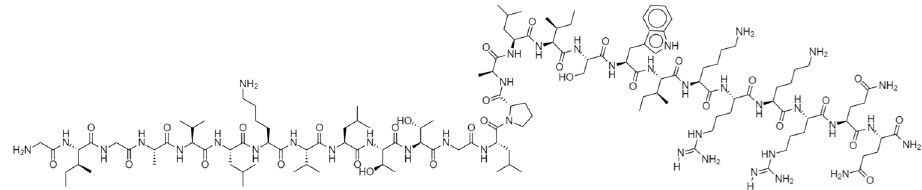
Figure 1. Chemical structure of MEL.